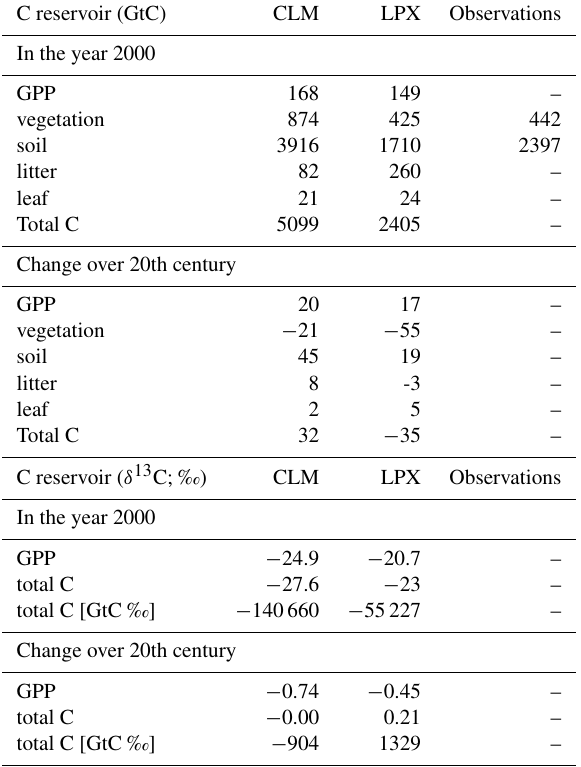
Table 2. Integrals and mean isotopic signatures of global carbon pools: steady state in the year 2000 (mean 1996–2005) and change over the 20th century for both models and an observational dataset (Carvalhais et al.,